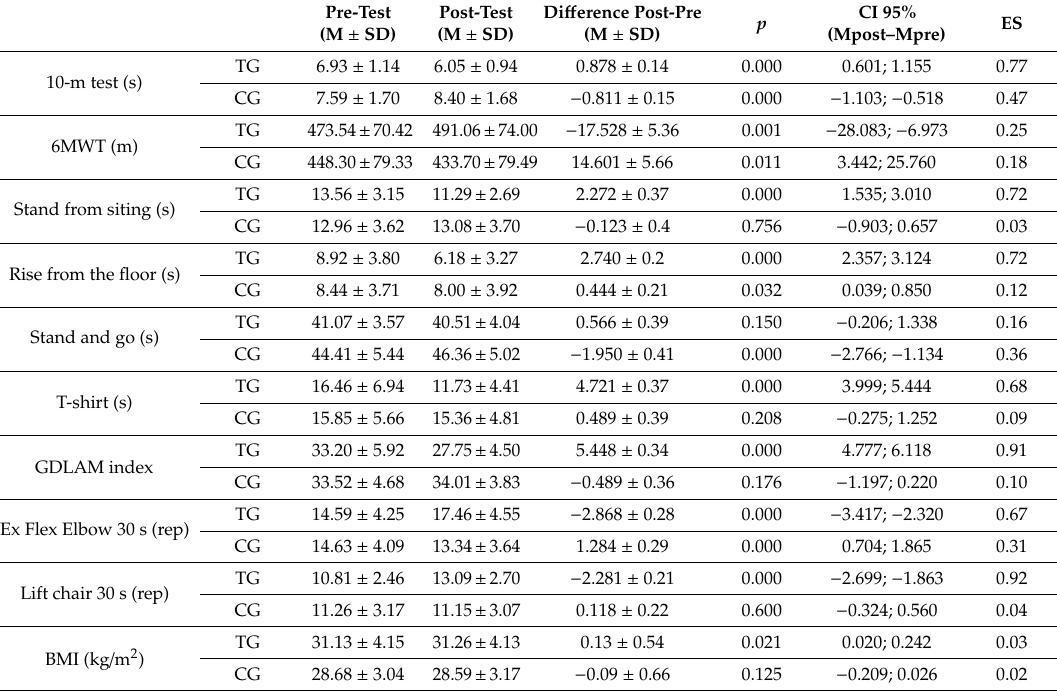
Table 3. Di ff erences pre- to post-test (intra-groups) for functional and fitness